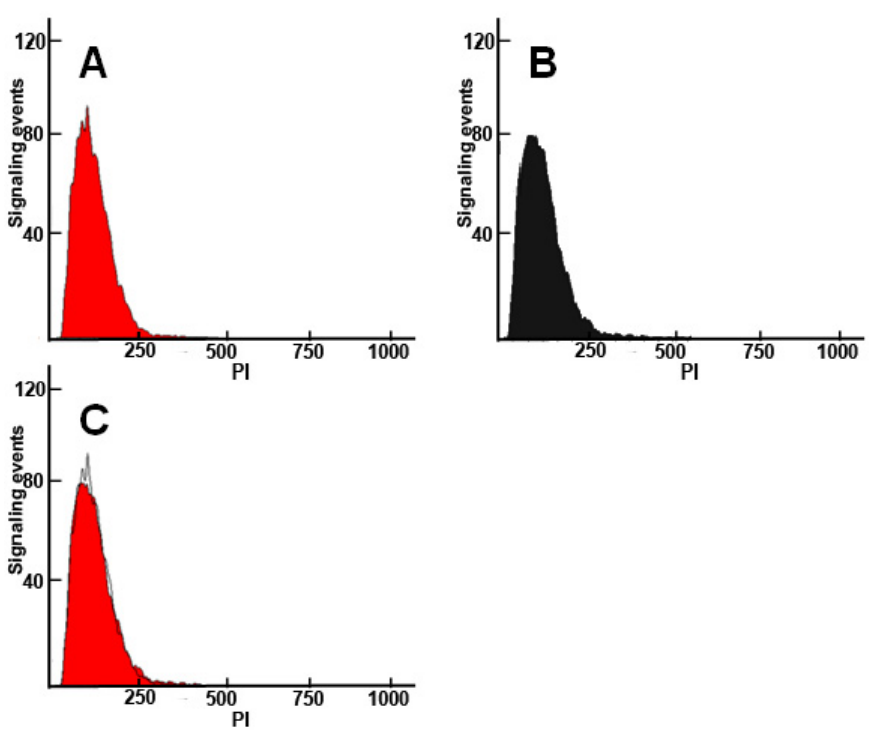
Figure 8. Flow cytograms of PI-stained E. coli . ( A ) Cells that over-expressed HCcp3; ( B ) Control cells without HCcp3 expression; ( C ) Overlay of the cytograms in ( A ) and ( B